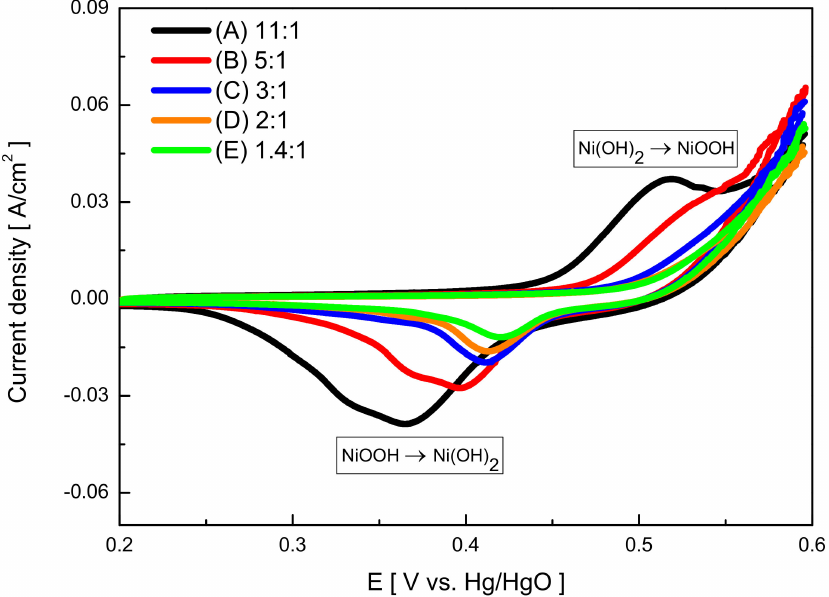
Figure 8. Results of cyclic voltammetry of electrodeposited Ni–Zn–Fe on Ni foam in the different Ni:Fe ratio of the bath (A), (B), (C), (D), (E) (Condition: scan rate = 1 mV/s).